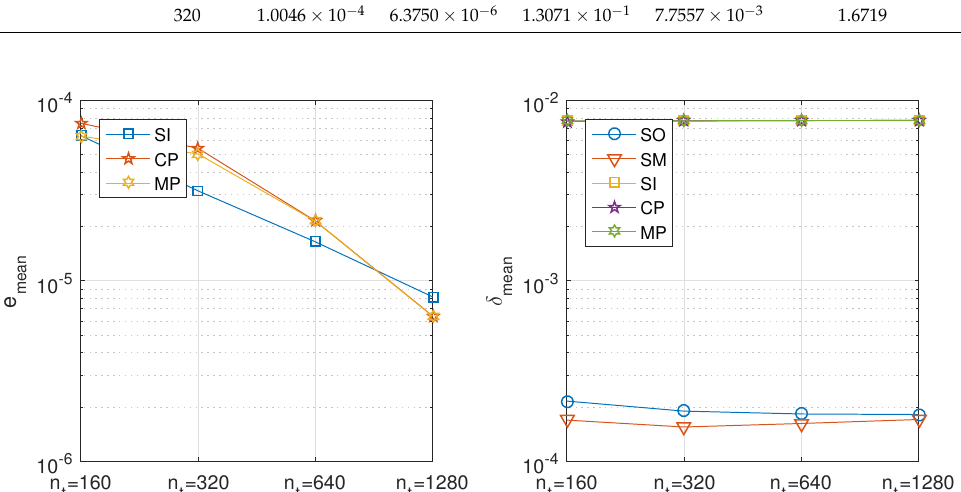
Figure 17. Fractional diffusion equation, balanced decomposition. Precision of the proposed methods: sequential iterative SI, classical parallel CP, and modern parallel MP, compared with the classical ones: sequential operator SO and Strang–Marchuk SM, for different number of time